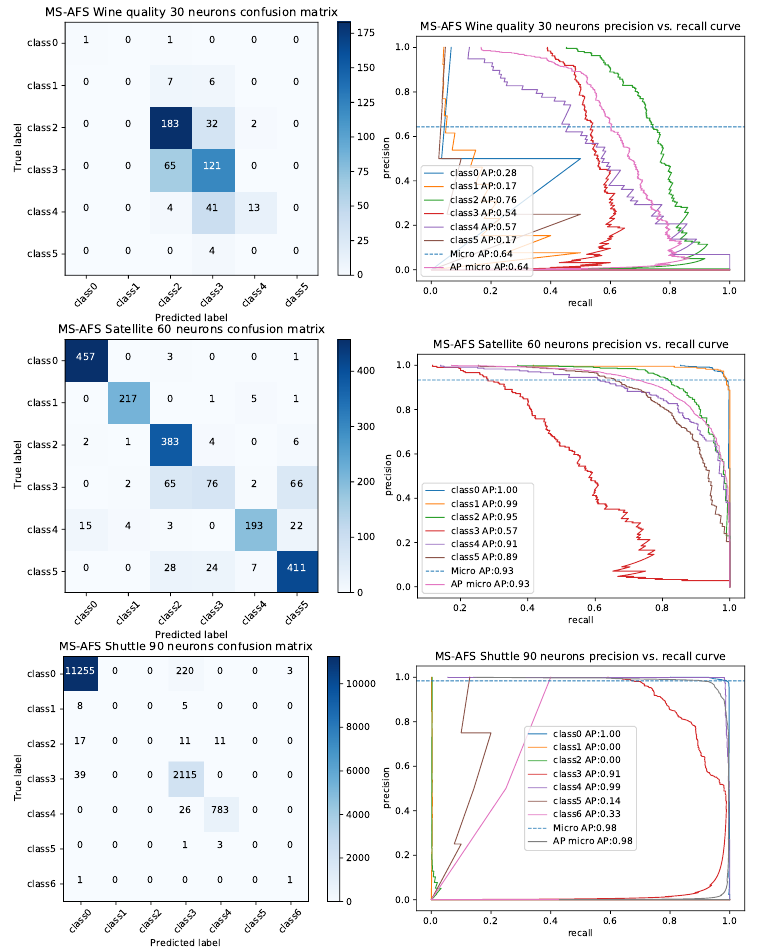
Figure 5. Generated confusion matrices and PR curves for some datasets by